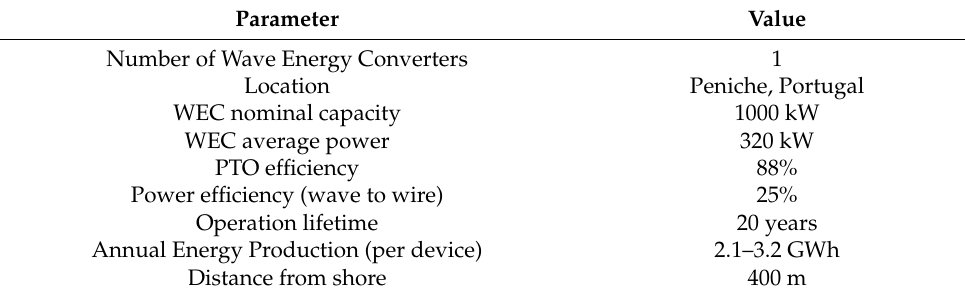
Table 1. Key parameters of MegaRoller. Parameter